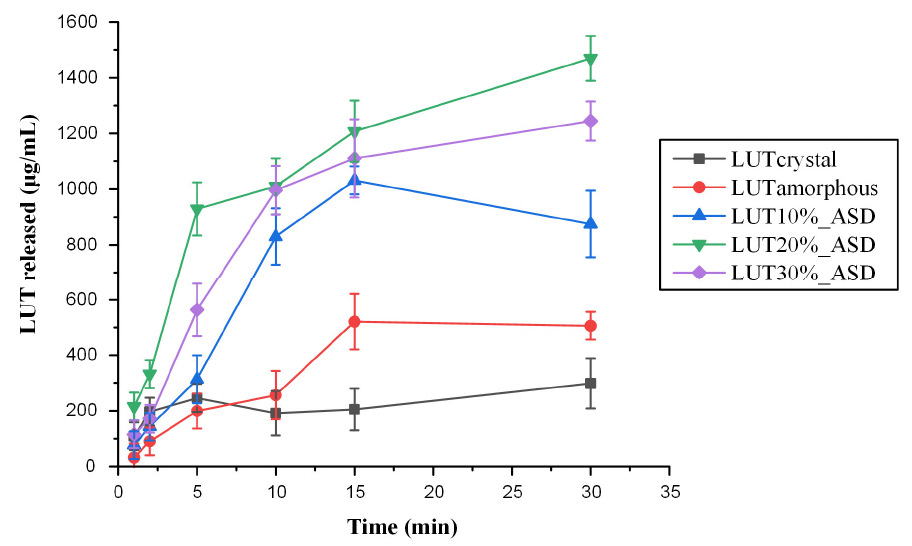
Figure 10. In vitro release profile of crystalline and amorphous LUT, as well as LUT–PVP ASDs at various drug concentrations.